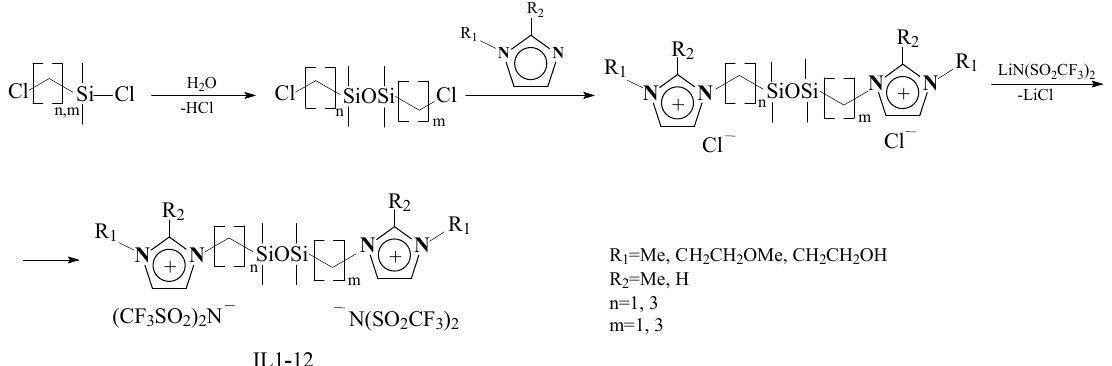
Scheme 1. The synthesis of disiloxane dicationic ionic liquids 1–12.